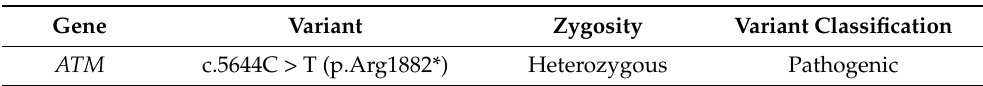
Table 1. Results of the genetic analysis testing of the patient’s blood performed through INVITAE multi-cancer